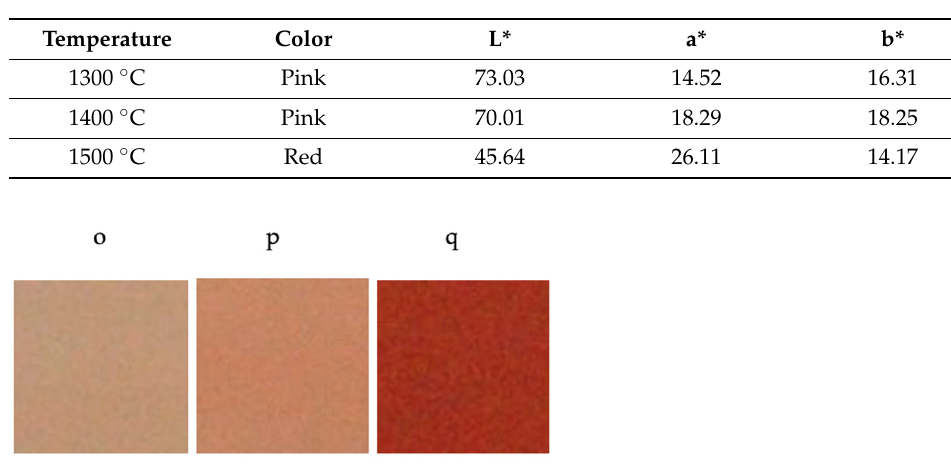
Figure 9. Color development of glazed tiles with fired pigment 1500 °C/6 h with 5% w / w CaF 2 addi- tion. ( i ) Y 0.99 Al 0.99 Cr 0.02 O 3 ; ( j ) Y 0.99 Al 0.98 Cr 0.03 O 3 ; ( l ) Y 0.98 Al 0.99 Cr 0.03 O 3 ; ( m ) Y 0.98 Al 0.98 Cr 0.04 O 3 ; ( n )